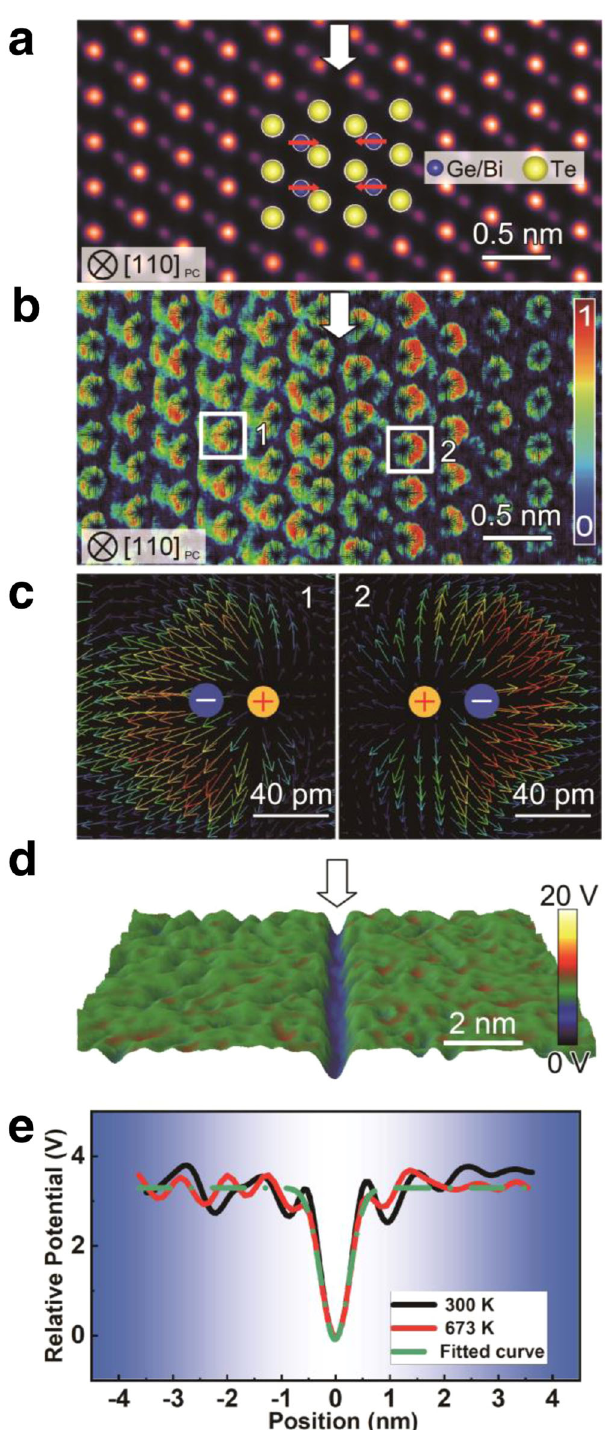
Fig. 2 | The structure of the QG. a An atomic-resolution HAADF image of a quantum gap in Ge 0.927 Bi 0.049 Te viewed along [110] PC zone axis. b Local electric fi eld of a quantum gap in Ge 0.927 Bi 0.049 Te deduced by differential phase-contrast imaging. c Themagni fi edlocalelectric fi eldsfromtheatomiccolumns1and2in( b ). d The reconstructed two-dimensional map of the potential distribution of a quantum gap in Ge 0.867 Re 0.003 Bi 0.087 Te by electron holography at 673K. e The potential pro fi les across the potential well at 300K and